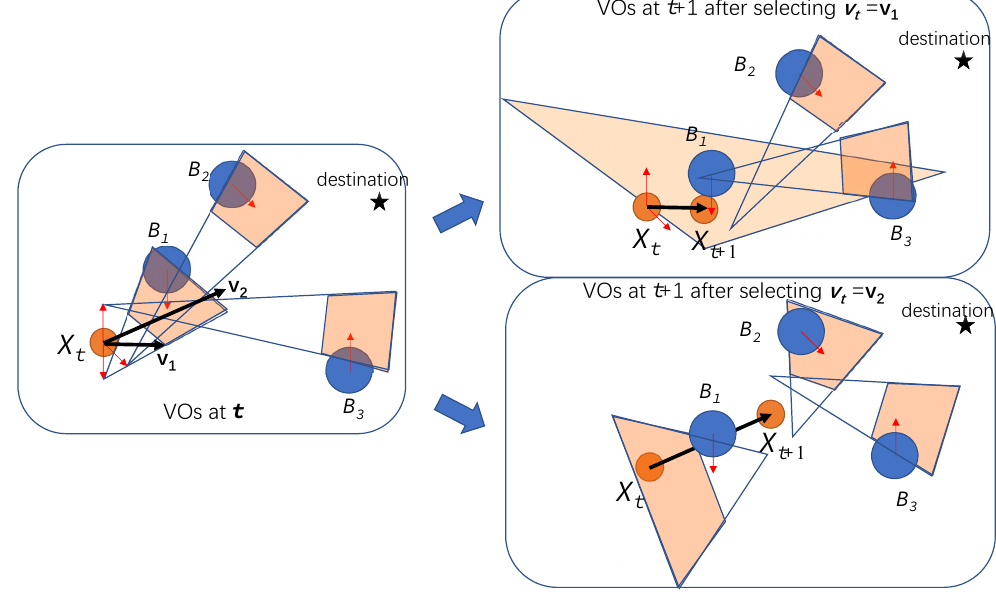
Figure 5. The greedy motion plan in one step may lead to a collision in the next